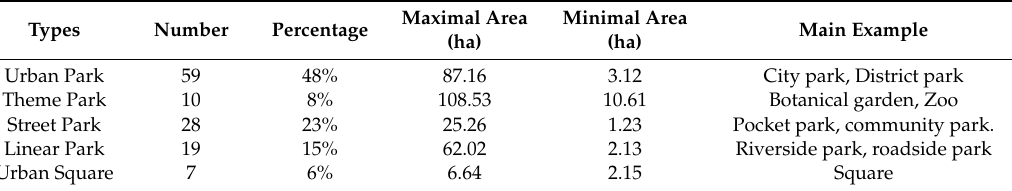
Table 2. Statistics and details of 123 sample parks by